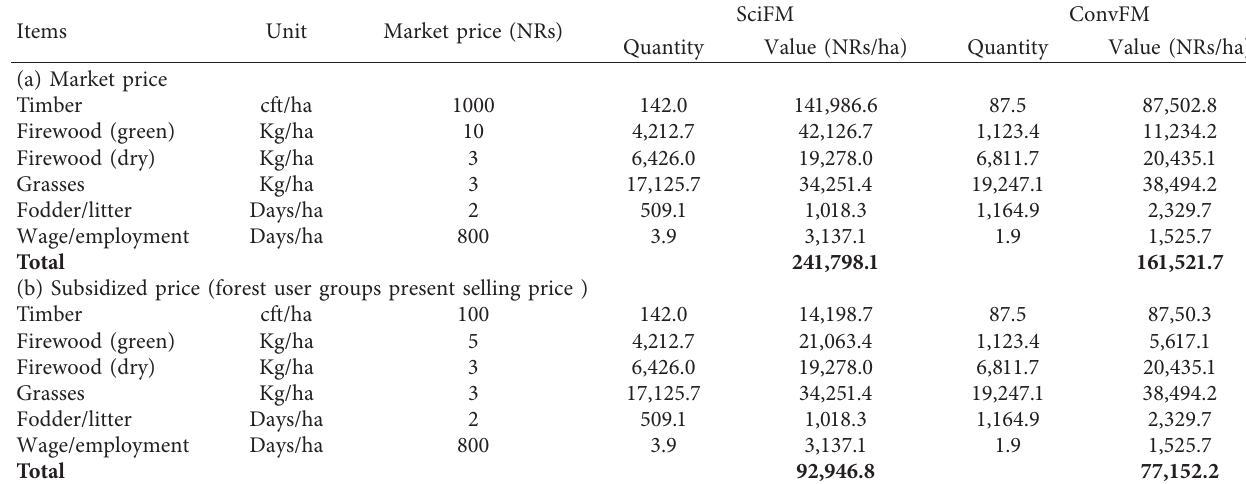
Table 5: Annual benefits per unit area (ha) by the forest management